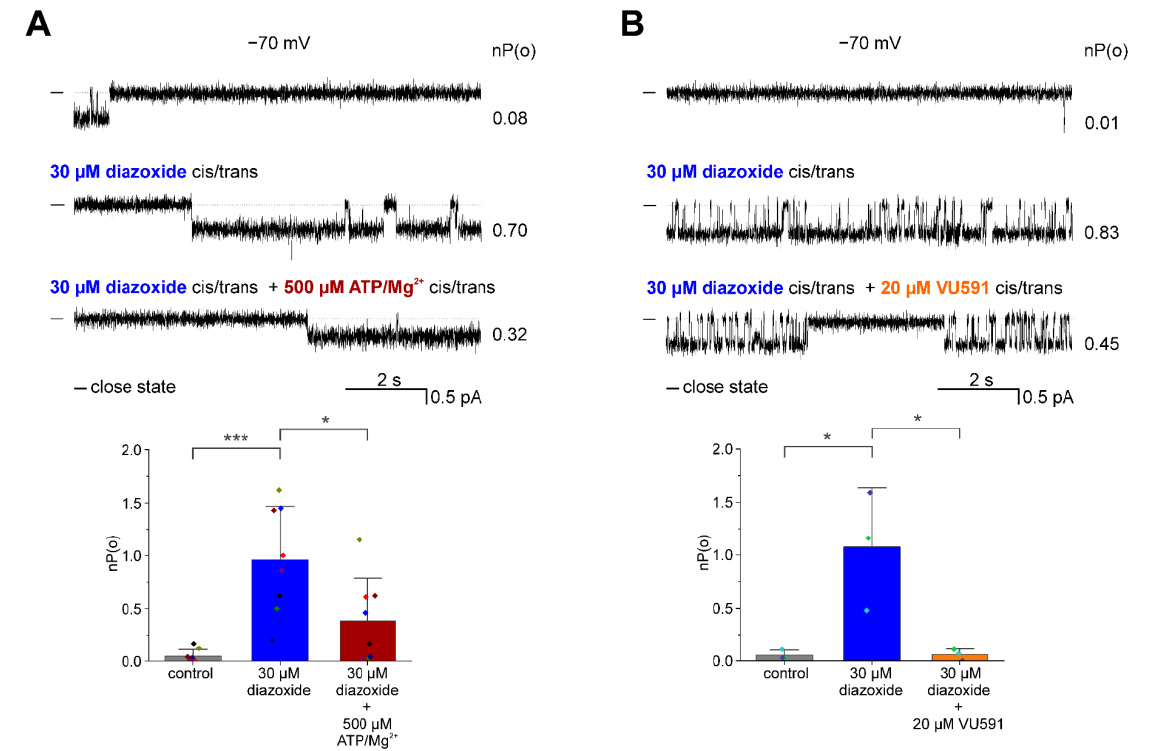
Figure 4. Inhibition of diazoxide-activated ROMK2 channels. ( A ) Inhibition of the diazoxide-activated channel by 500 µM ATP/Mg 2+ . Top panel: Representative single-channel recordings at − 70 mV under control conditions, in the presence of 30 µM diazoxide, or 30 µM diazoxide and 500 µM ATP/Mg 2+ . Lower panel: channel open probability nP(o) under the control conditions, after the addition of 30 µM diazoxide, or 30 µM diazoxide and 500 µM ATP/Mg 2+ ( n = 8). ( B ) Inhibition of the diazoxide-activated channel by VU591. Top panel: Activation of the ROMK2 channel by 30 µM diazoxide followed by inhibition by the addition of 20 µM VU591. Lower panel: representative single-channel recordings at − 70 mV under control conditions in the presence of 30 µM diazoxide and after the addition of 20 µM VU591. Lower panel: channel open probability, nP(o), in control conditions, in the presence of 30 µM diazoxide, or 30 µM diazoxide and 20 µM VU591 ( n = 3). All modulators were applied to the cis and trans compartments simultaneously. “ - ” indicates the closed state of the channel. The results related to channel open probability are presented as means ± SD. * p < 0.05, *** p < 0.001.